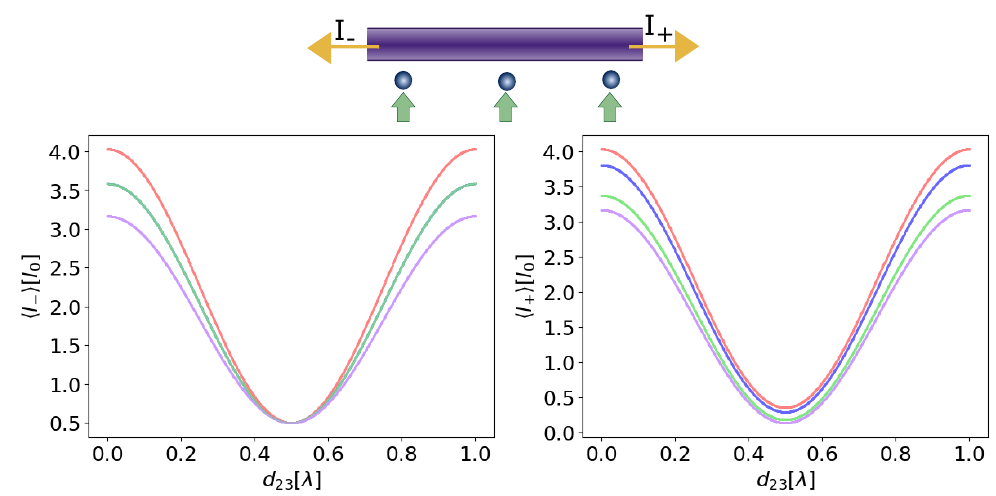
Figure 7. State-dependent light intensities emitted from the fiber to the left I − and to the right I + for a system with three particles. Here, the distance between the first two particles stays constant with d 12 = λ 0 , while we vary the position of the third particle. Red lines correspond to the ground state | 000 (cid:105) , blue lines to the single excited state | 100 (cid:105) , green lines to a doubly excited state | 011 (cid:105) and purple lines corresponds to the state | 111 (cid:105) . Note that in the left figure the green and blue lines overlap.